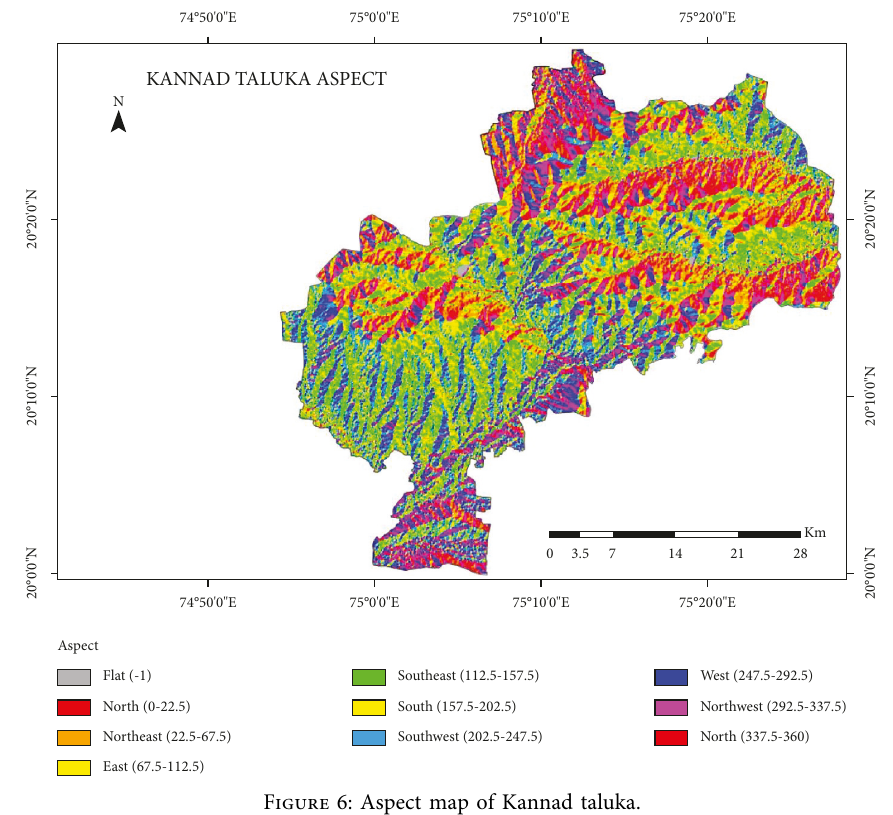
Figure 6: Aspect map of Kannad taluka.